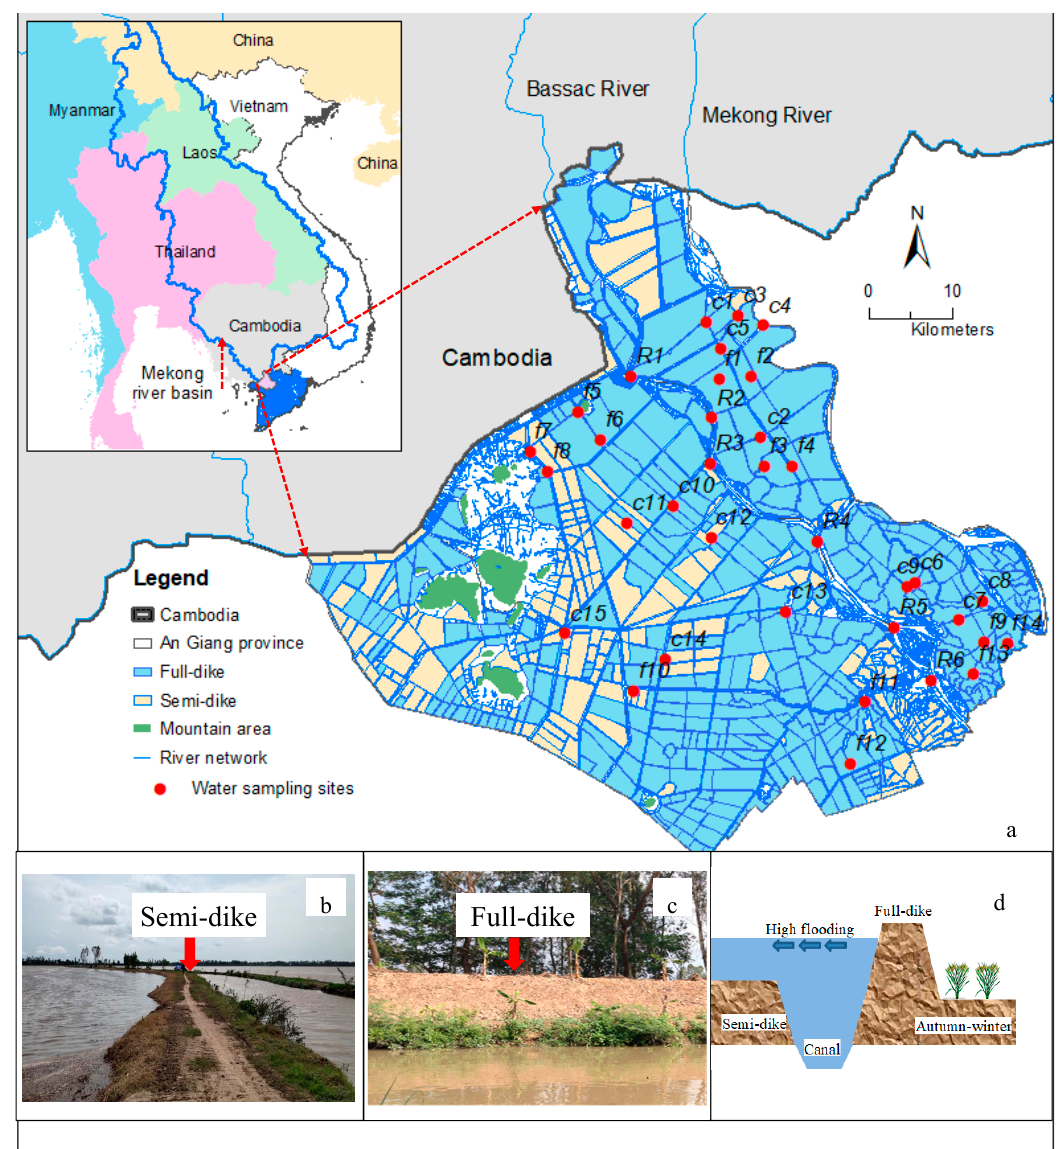
Figure 1. ( a ) Study area and surface water quality monitoring location in An Giang province, Vietnam. ( b , c ) Photos of a semi-dike and a full-dike (taken during field work in the Mekong Delta in 2017). ( d ) Sketch of a cross-section of a typical dike system. Note: R: sampling site in the main river, c: sampling site in the primary canal, f: sampling site in the secondary canal (field canal).